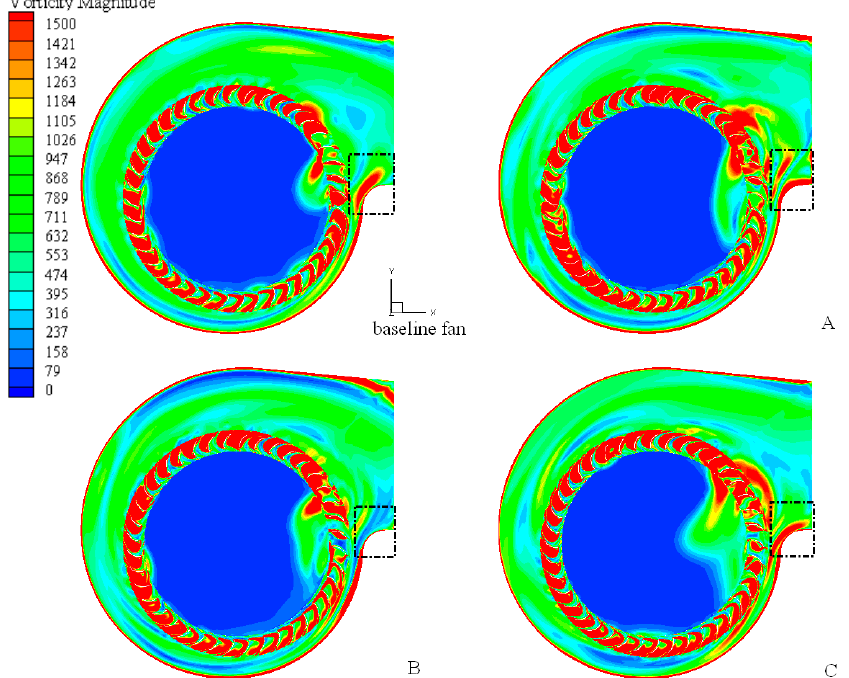
Figure 20. Contour of vorticity magnitude for the z = 75 mm plane at a high flow rate Q / Q n = 1.760: ( A ) model-A; ( B ) model-B; ( C )